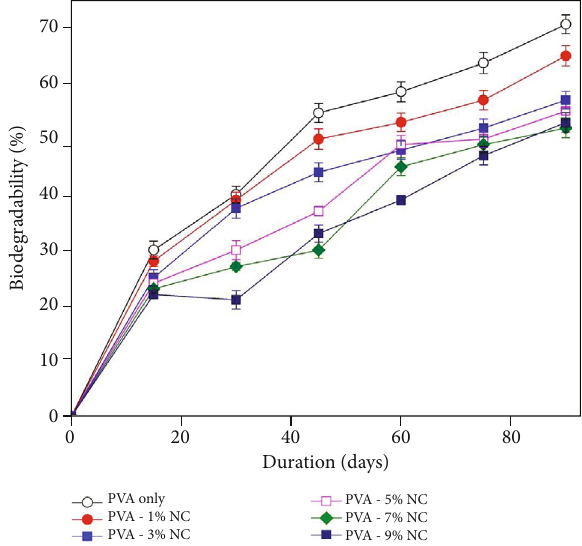
n tt a m i n s a T r